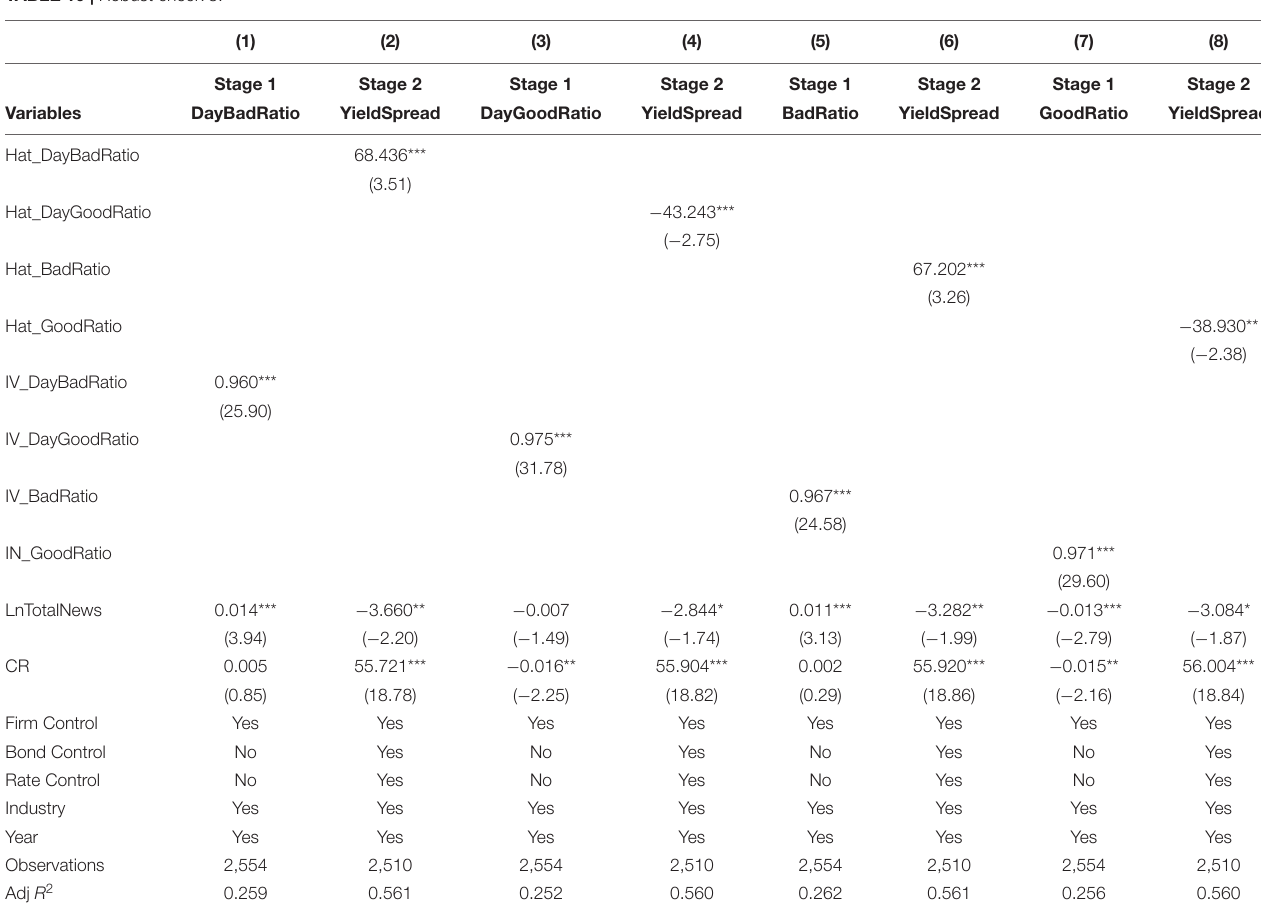
TABLE 10 | Robust check